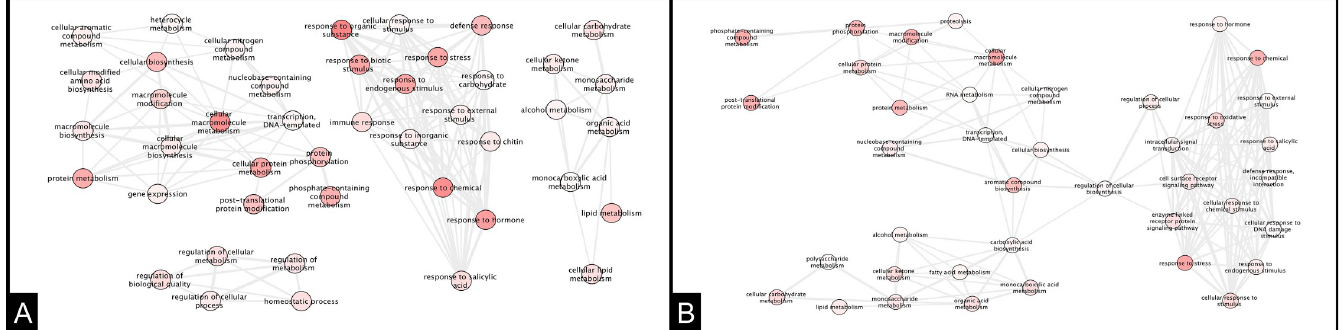
Fig 8. Interaction network of DEG in oil palm clones at 120 hpi of infection A: Ortet 34 resistant B: Ortet 57 susceptible.